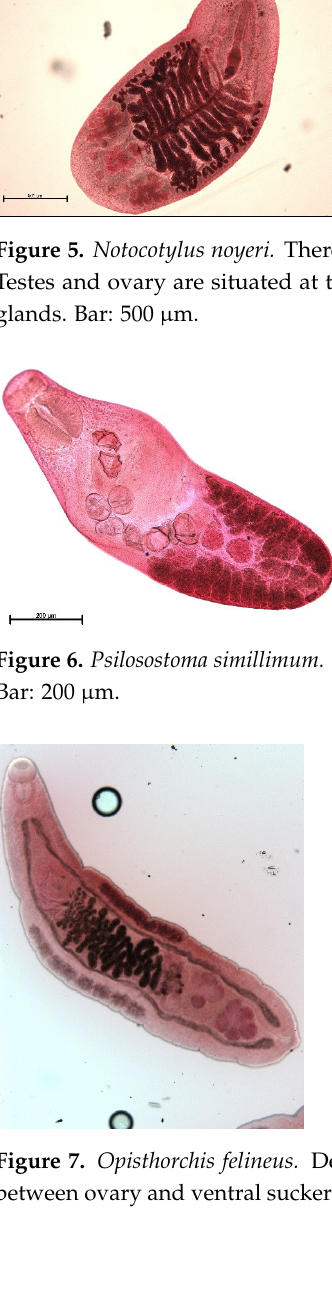
Figure 8. Three cysts of Strobilocercus fasciolaris the larval stage of Hydatigera taeniaeformis in the liver of a muskrat.